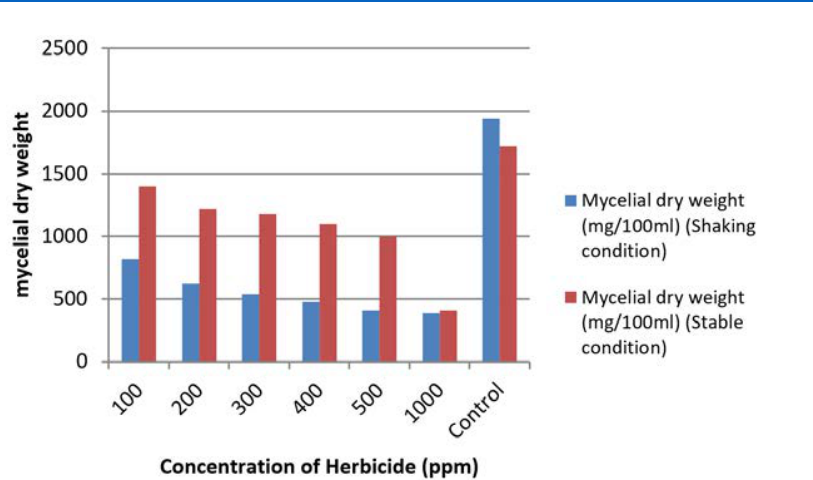
Fig. 6. Growth of A. terreus in Herbicide (pretilachlor) amended medium in Shaking and stable culture